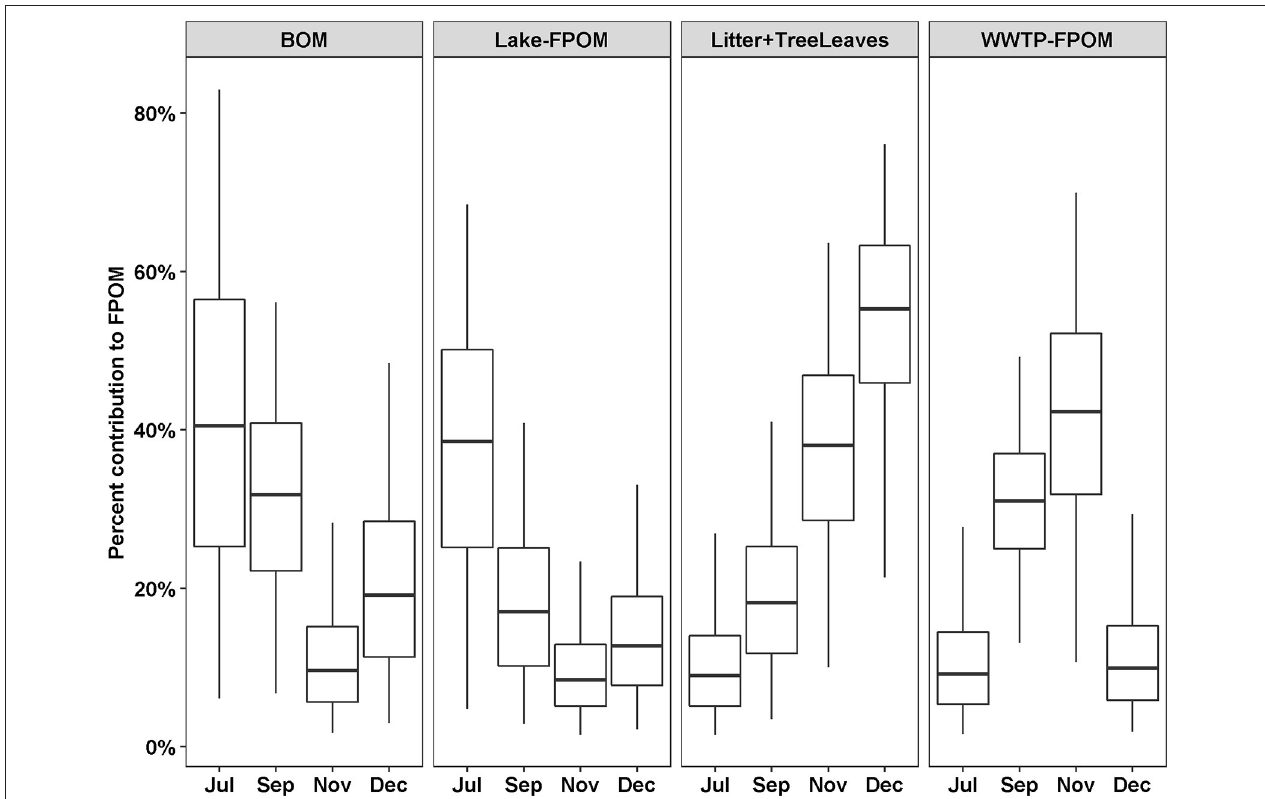
FIGURE 4 | Percent feasible contributions to FPOM from four sources depending on the month. Contributions were estimated using SIMMR with three isotope tracers, δ 13 C, δ 15 N, and δ 2 H. Boxes represent the median and interquartile range; whiskers represent 2.5 and 97.5 percentiles.